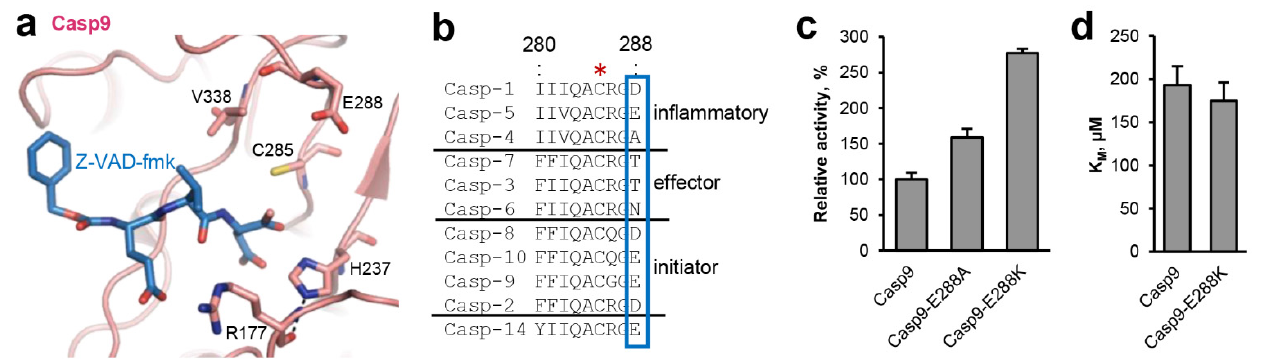
Figure 3. A pKa tuning switch is also implemented in caspases. ( a ) Zoom-in view on the active site of caspase-9 (pdb 1jxq). Active site residues are shown in pink sticks, the Z-VAD-fmk inhibitor is shown in blue sticks. ( b ) Sequence alignment of human caspases. The catalytic Cys285 residue is indicated by a red star. The pKa switch at position 288 is highlighted by a blue box. Uniprot IDs are specified in the material and methods section. ( c ) Activity of Δ CARD-caspase-9 and the Δ CARD-caspase-9-E288K mutant measured as turnover of the VAD-AMC substrate. ( d ) K M values of Δ CARD-caspase-9 and the Δ CARD-caspase-9-E288K mutant determined using the VAD-AMC substrate.